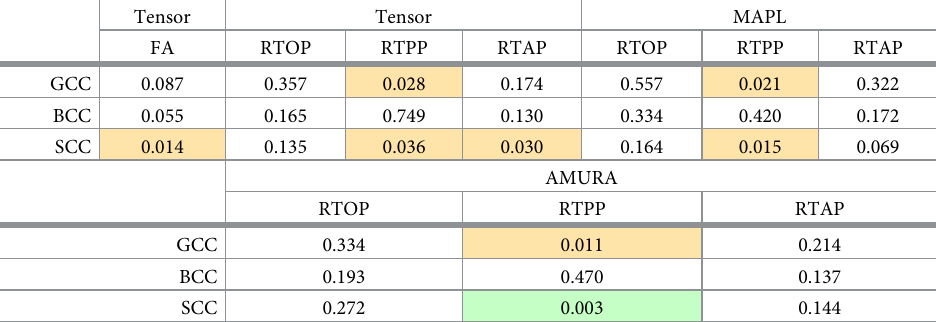
Table 7. Two-sample t -tests for each measure and at each section of the corpus callosum (the lower the better). The p -values represent the probability that the measure has identical means for both controls and patients. Differences with statistical significance above 99% (resp. 95%) are highlighted in green (resp. amber). Tensor Tensor MAPL FA RTOP RTPP RTAP